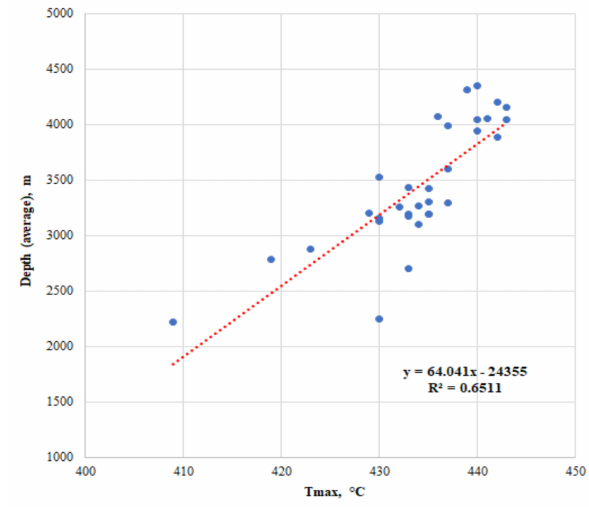
Figure 15. T max ( ◦ C) variation vs. depth (m).